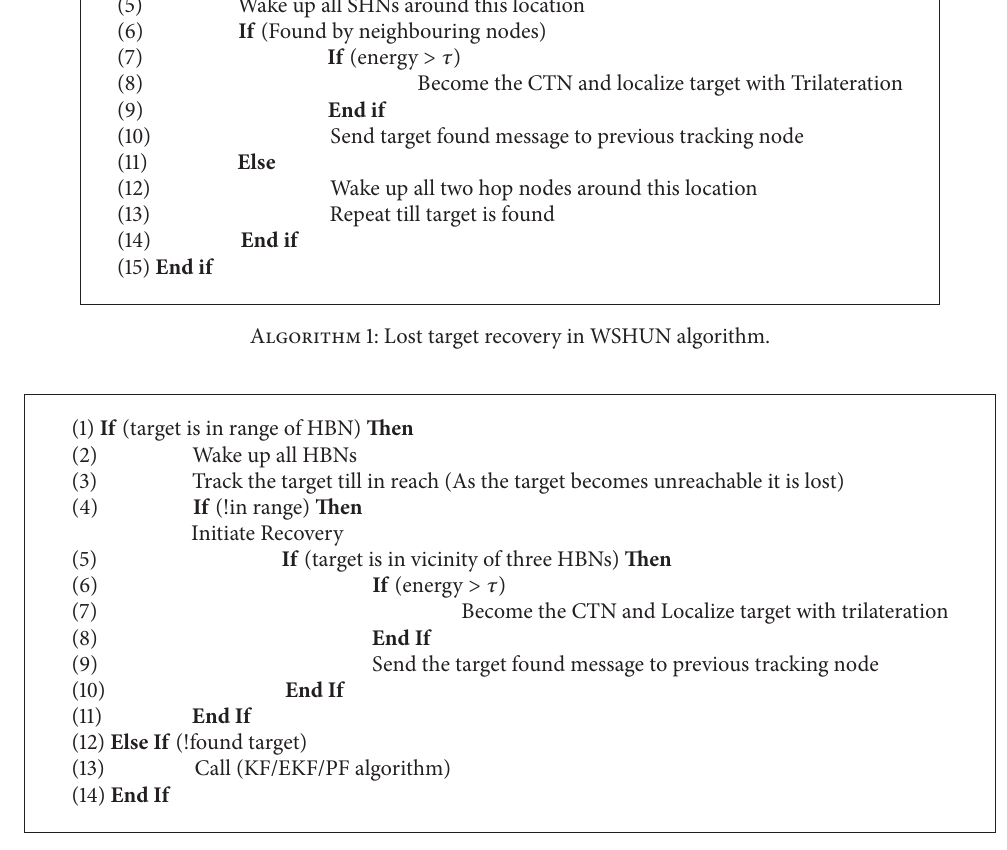
Algorithm 2: Lost target recovery in WSHAN